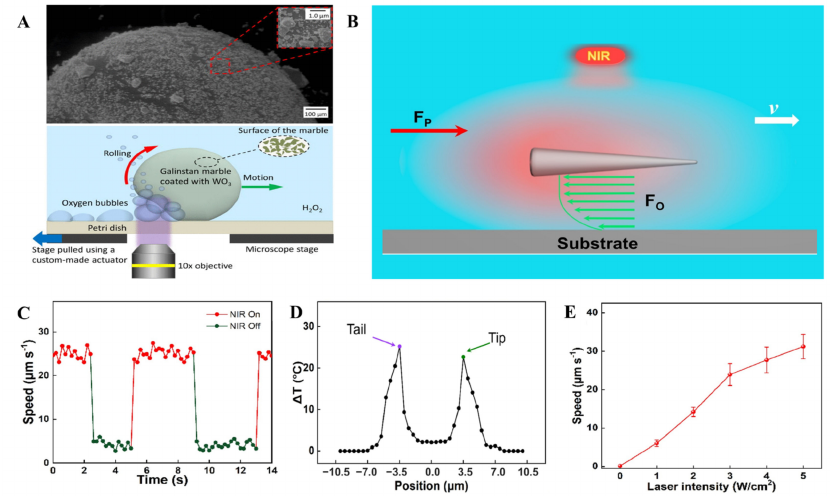
Figure 15. Light-driven MLMTs. ( A ) The schematic illustration of the mechanism of NIR light-driven MLMTs. ( B ) The “off/on/off” control of MLMTs. ( C ) Speed control of MLMTs by various laser power. ( D ) The temperature of the water along the long axis of MLMTs [82]. ( E ) Schematic of light-powered LM motors coated with WO 3 particles [117].